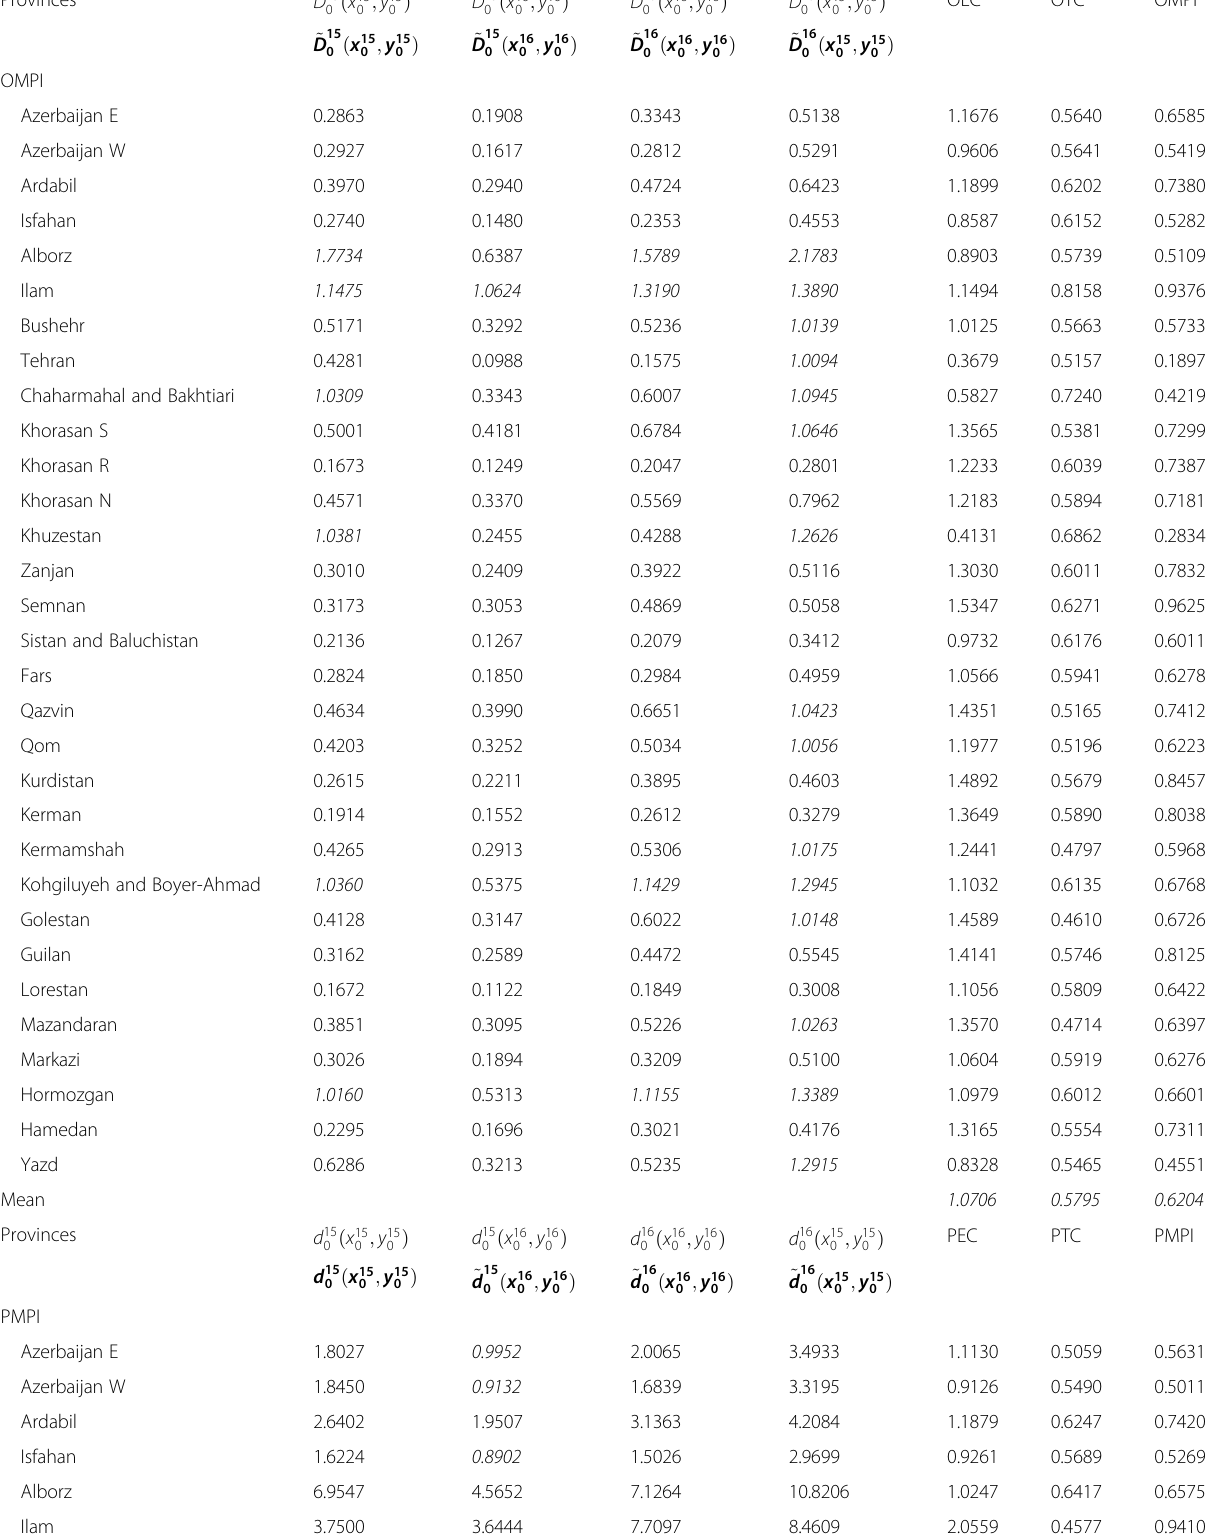
Table 8 OMPI and PMPI values for the 31 Iranian provinces (2015-2016)